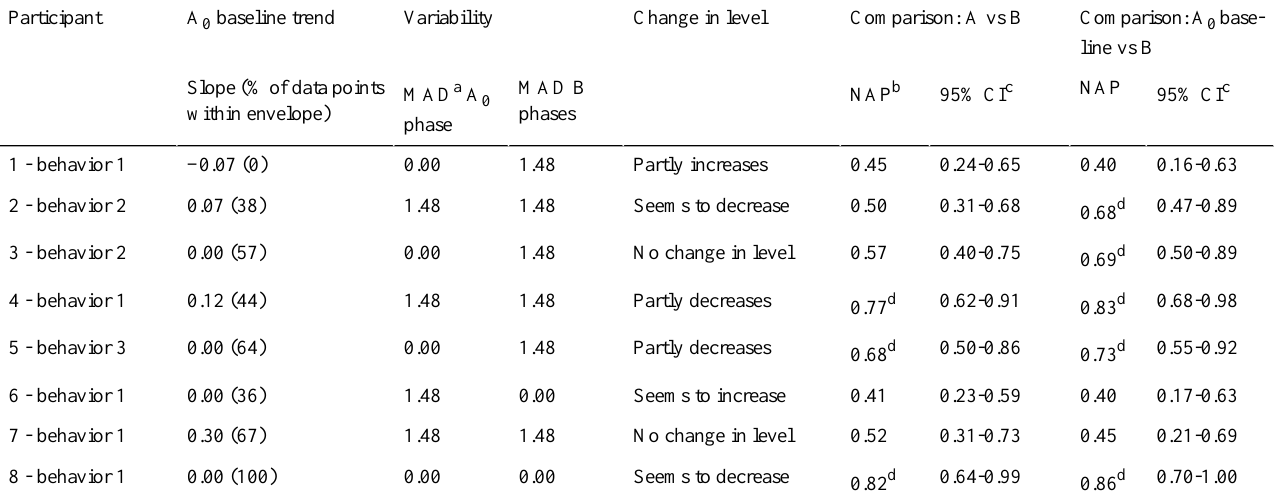
Table 6. Results from visual analysis (baseline trend, variability, and change in level) and nonoverlap of all pairs on disruptive classroom behavior.